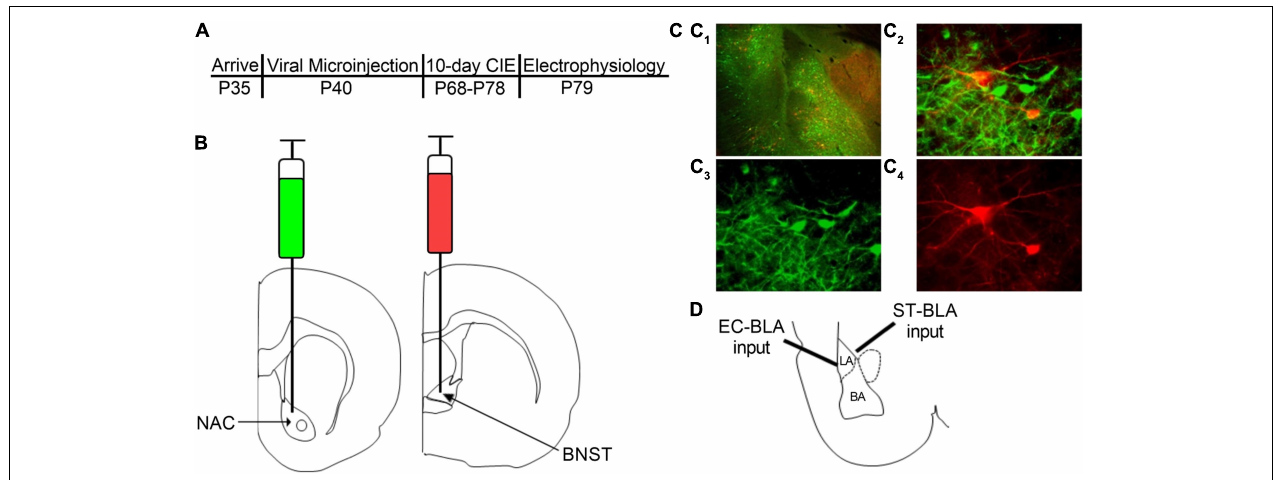
FIGURE 1 | Retrograde labeling of BLA-NAC and BLA-BNST neurons. (A) Timeline of experimental procedures. (B) Schematic illustrating AAVrg-CAG-GFP into the NAC (AP + 1.80 mm, ML ± 1.5 mm, DV 6.72 mm) and AAVrg-CAG-tdTomato into the BNST (AP –0.24 mm, ML ± 0.80 mm, DV 6.45 mm). (C 1 ) 4X overlay of GFP-expressing BLA-NAC and tdTomato-expressing BLA-BNST neurons. (C 2 ) 40X overlay of GFP-expressing BLA-NAC and tdTomato-expressing BLA-BNST neurons. (C 3 ) GFP expression in BLA-NAC neurons under 40 × magnification. (C 4 ) tdTomato expression in BLA-BNST neurons under 40 × magnification. (D) Schematic illustrating the placement of the stimulating electrode when activating the EC-BLA and ST-BLA